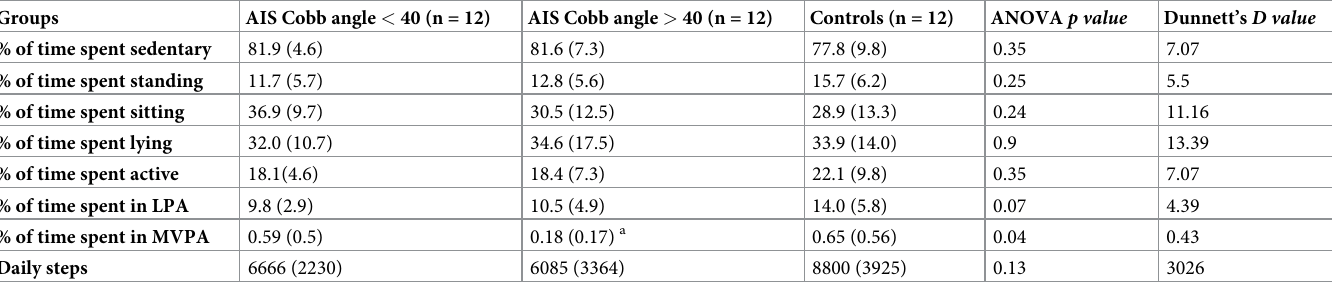
Table 4. Activity and sedentary behavior during weekend days. Mean